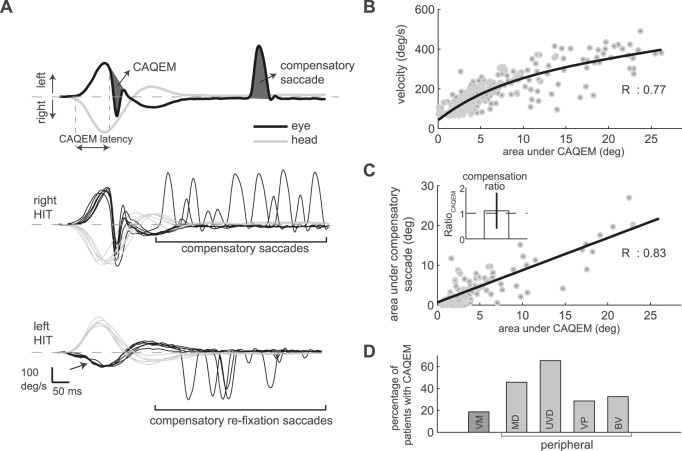
Example, saccade main sequence, compensation and clinical diagnoses.A: Top panel shows representative eye (black) and head (gray) velocity traces during head impulse testing (HIT). The covert anti-compensatory quick eye movement (CAQEM) during the head movement has a latency of 96 ms. The CAQEM is compensated for by a saccade (dark gray areas within the CAQEM velocity curve and that of the compensatory saccade match). Middle and bottom panels show eye and head traces for right and left HIT from one subject. CAQEMs on the right side are compensated for by saccades. There is a vestibulo-ocular reflex (VOR) gain deficit on the left side (note how eye velocity does not match head velocity, arrow) with compensatory re-fixation saccades toward the target. B: CAQEM peak velocity as a function of amplitude (area under the curve) for all CAQEMs from all subjects. An exponential fit (black line) shows that CAQEMs follow the saccade main sequence. C. Regression line (black) between the area under the saccades plotted against the area within the corresponding CAQEM indicates that saccades are compensatory (each dot represents the mean of one subject). Inset shows the mean compensation ratio (RatioCAQEM and SE) calculated by dividing the area under the compensatory curve by that of the CAQEM. D. Percentage of patients with CAQEMs distributed for the different clinical diagnoses established by neuro-otological experts according to current standards: vestibular migraine (VM), Menière’s disease (MD), unilateral peripheral vestibular deficit (UVD), vestibular paroxysmia (VP), and bilateral vestibulopathy (BV). The percentage of patients with CAQEMs is higher in peripheral vestibular disease (gray), e.g., Menière’s disease, than in vestibular migraine (dark gray). UVDs have the highest percentage of CAQEMs.